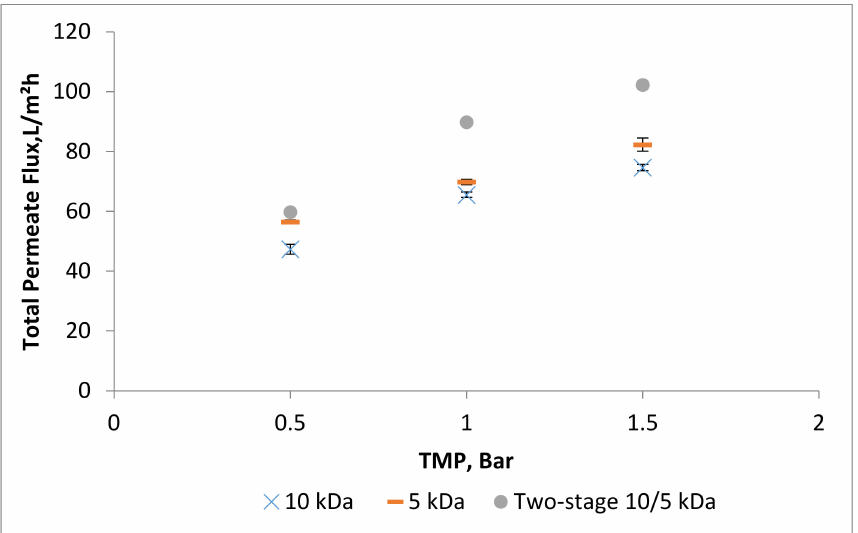
Figure 5. Total permeate flux at different trans-membrane pressures for single and two-stage UF